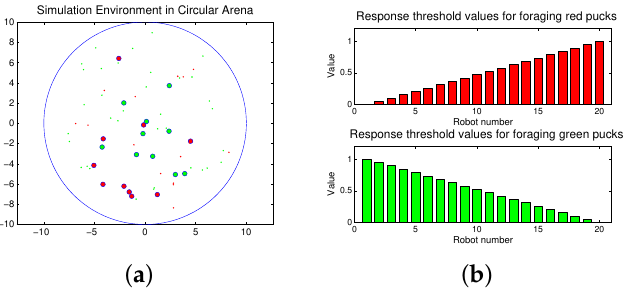
Figure 1. ( a ) Snapshot of the simulation environment; ( b ) response threshold values of robots for two